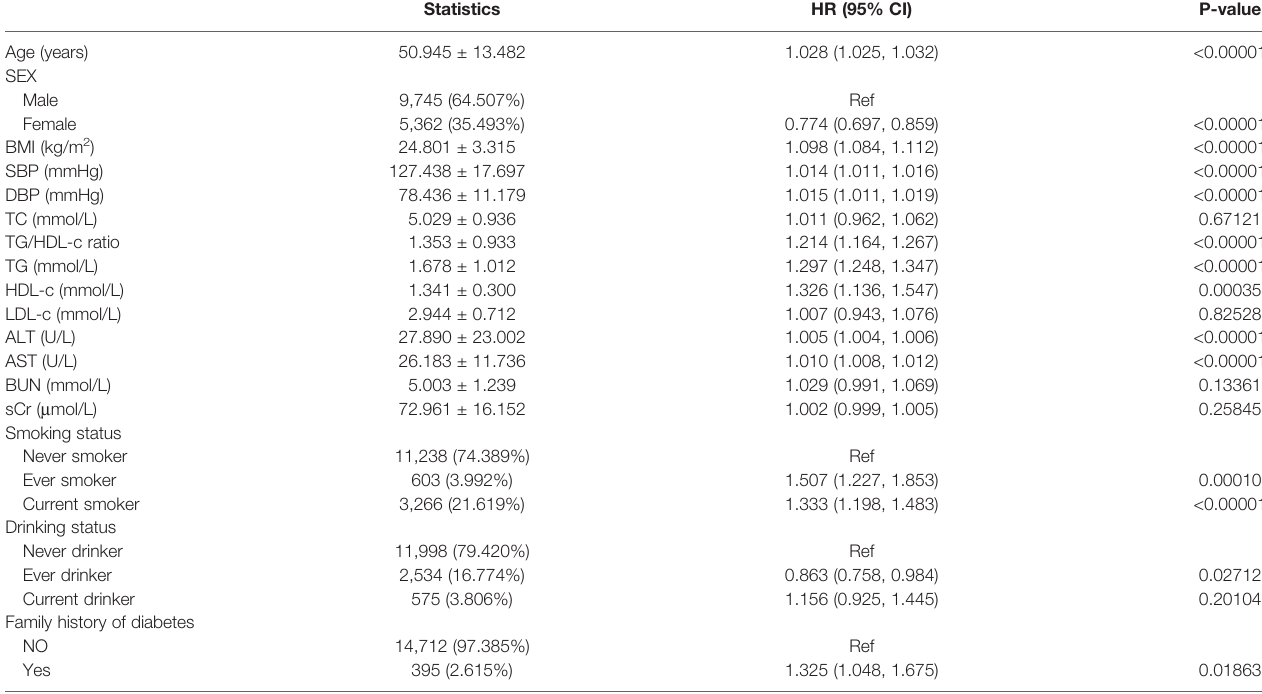
TABLE 3 | Factors in fl uencing risk of diabetes in patients with prediabetes analyzed by univariate Cox proportional hazards regression. Statistics HR (95% CI) P-value